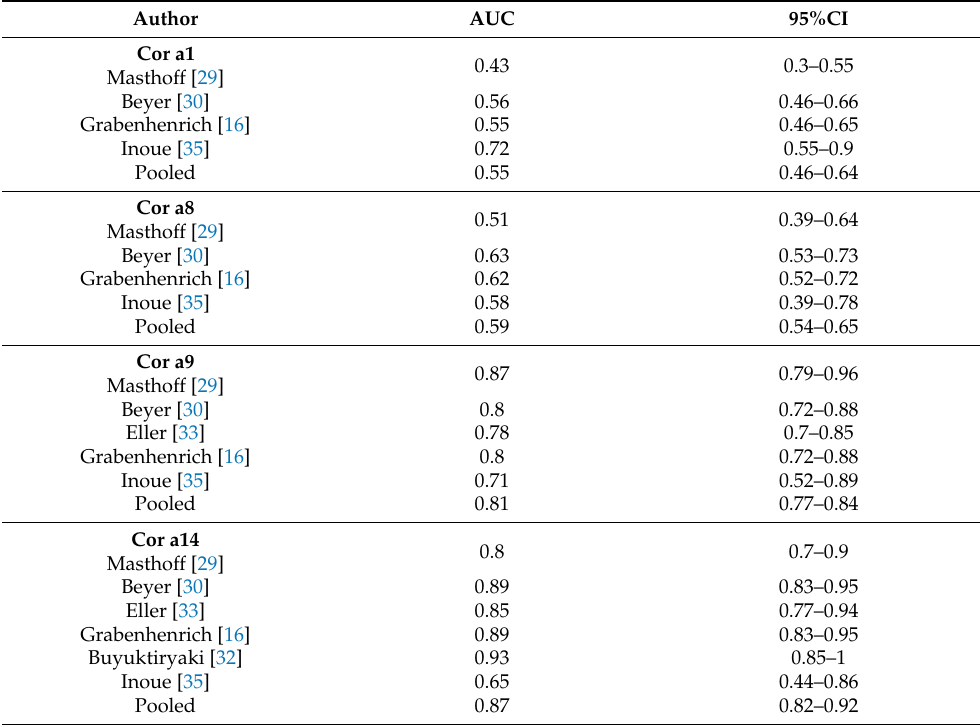
Table 3. Area under the curve (AUC) of sIgE to hazelnut components.